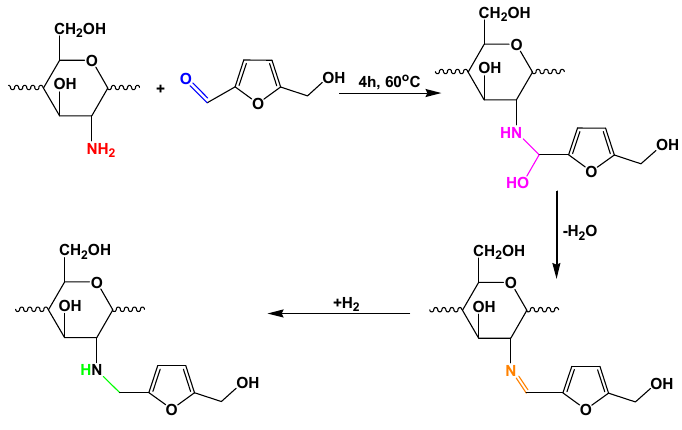
Figure 1. Synthesis route of CS-HMF.